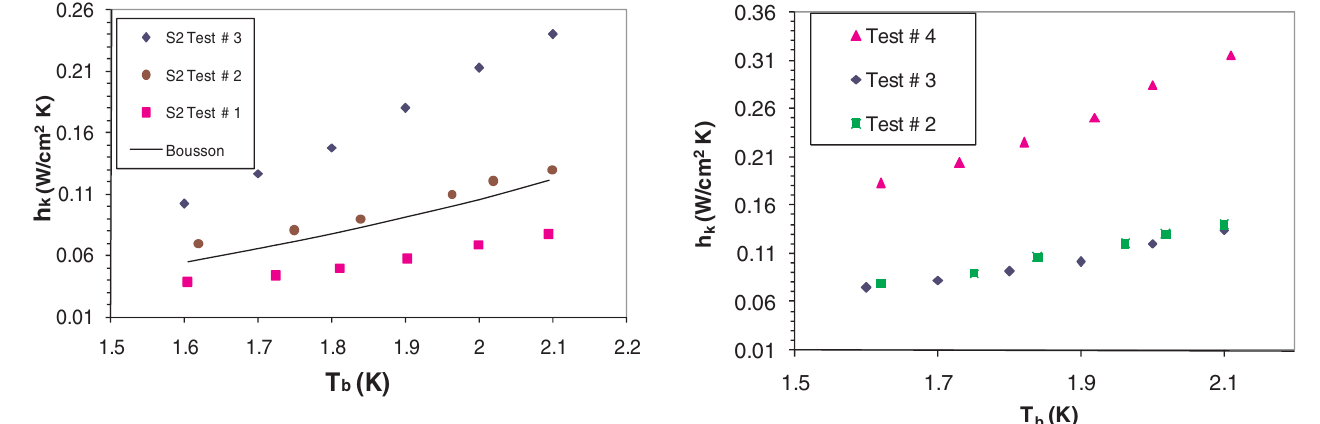
FIG. 15. (Color) Kapitza conductance for sample S1 comparison before (tests #2 and #3) and after titanification (test #4).